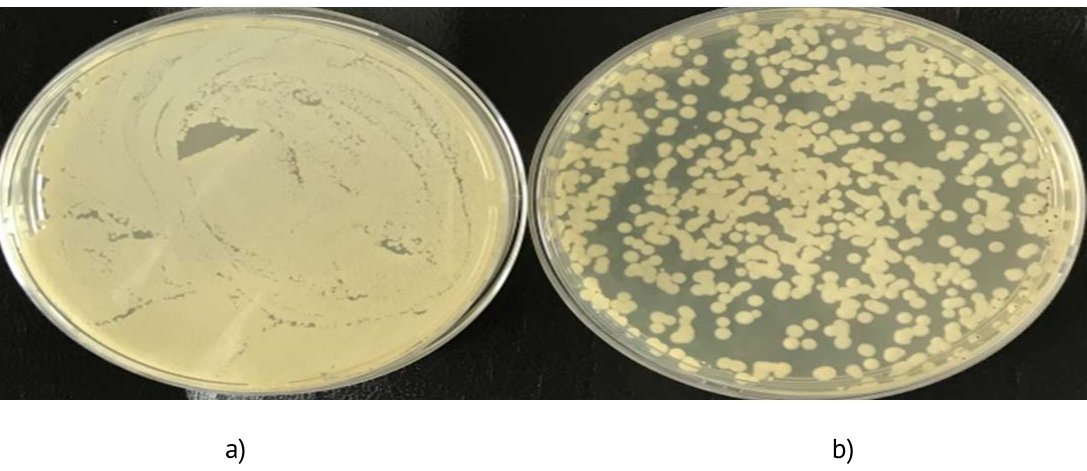
Figure 5. Growth of Klebsiella pneumoniae strains in sausage samples tested after 96h: a) control sample; b) hawthorn